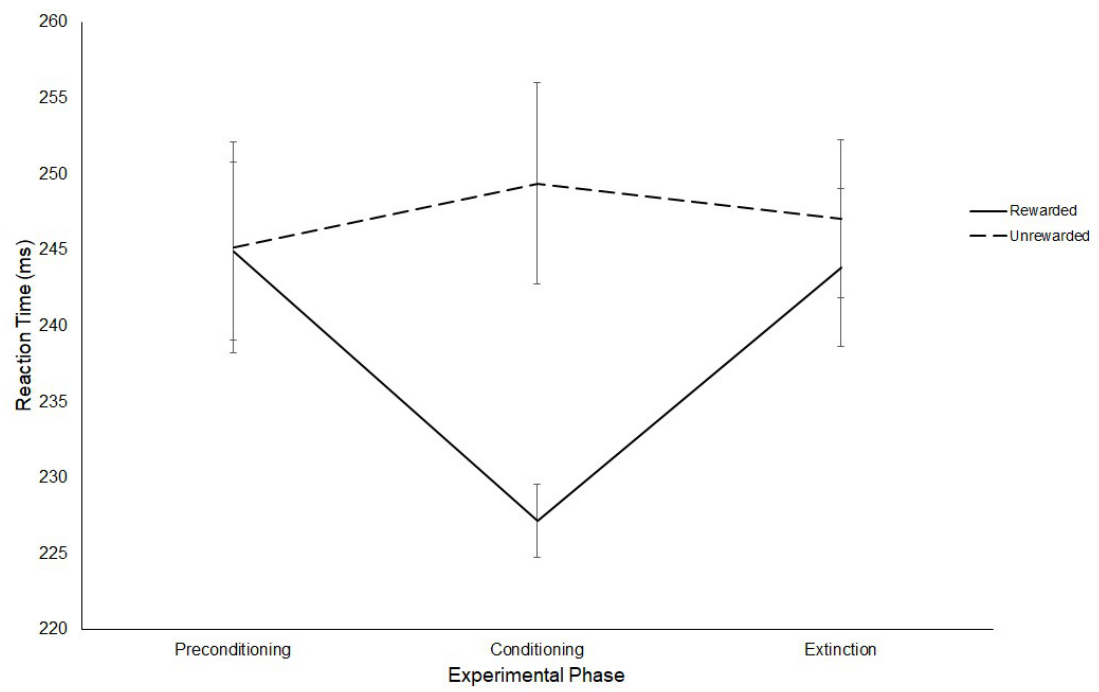
Figure 8. Latency of prosaccades to the rewarded and unrewarded hemifields across the preconditioning, conditioning and extinction phases of the reward paradigm in Experiment 2. Error bars show +/−1 SEM.